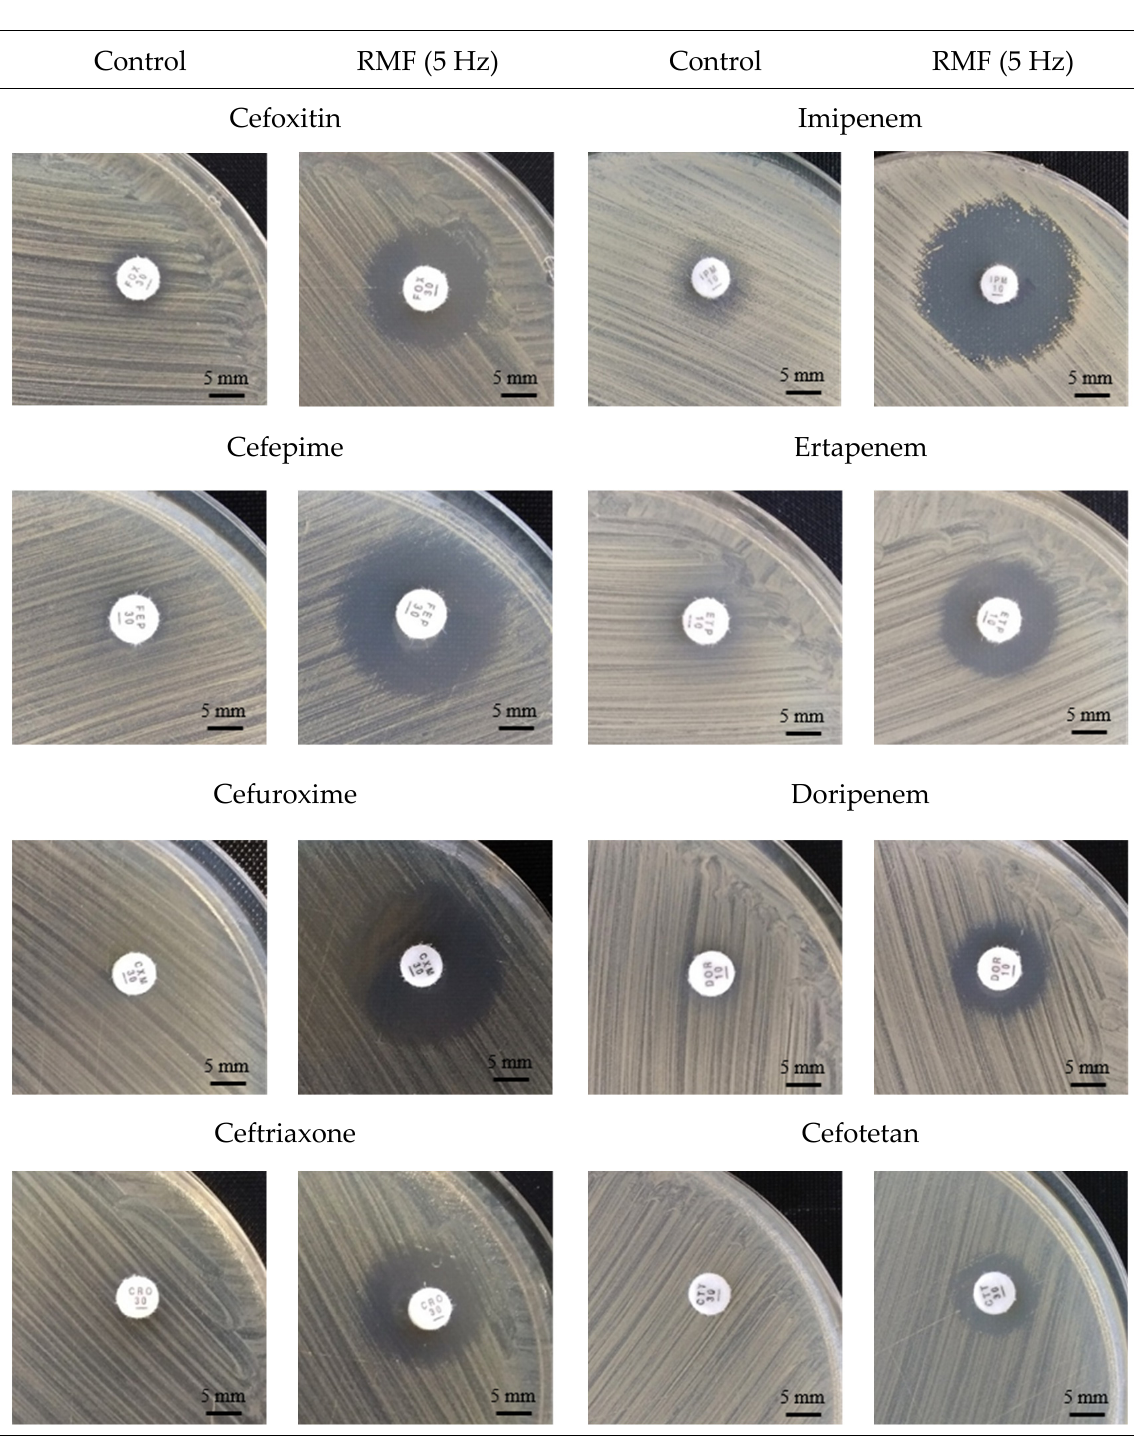
Figure 2. Representative pictures of growth inhibition zones (mm) in control and RMF-exposed (5 Hz) MRSA 1 cultures around discs with β -lactam antibiotics.